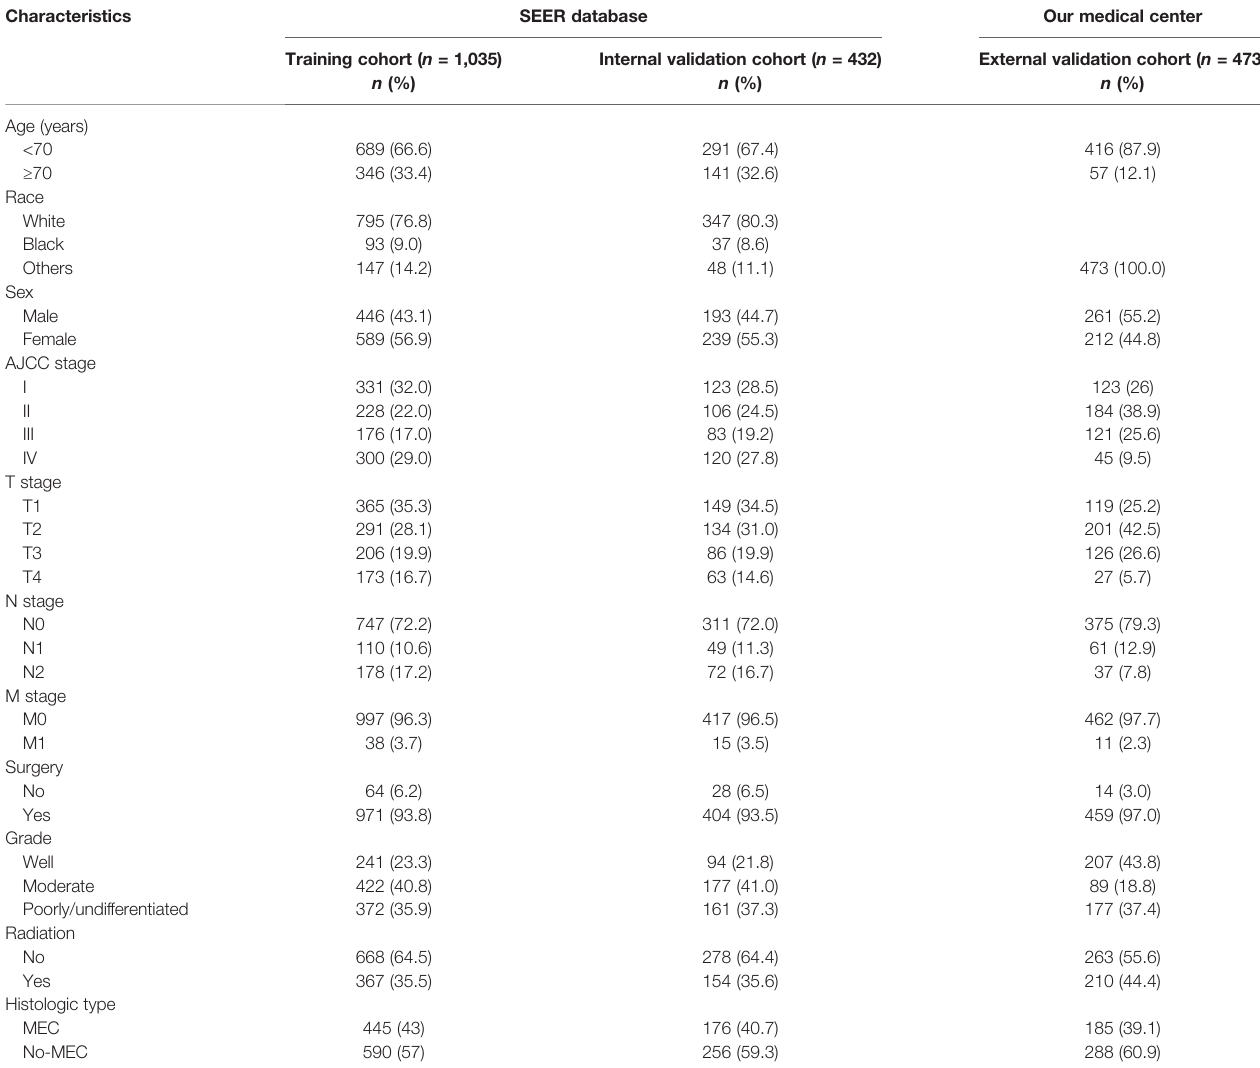
TABLE 1 | Basic characteristics of parotid cancer patients in the training, internal validation, and external validation cohorts.